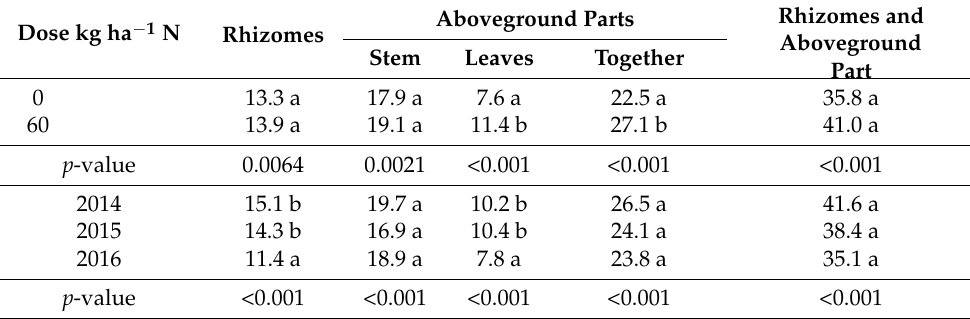
Table 4. Potassium uptake of the giant miscanthus in g m −2 (average for 2014–2016).